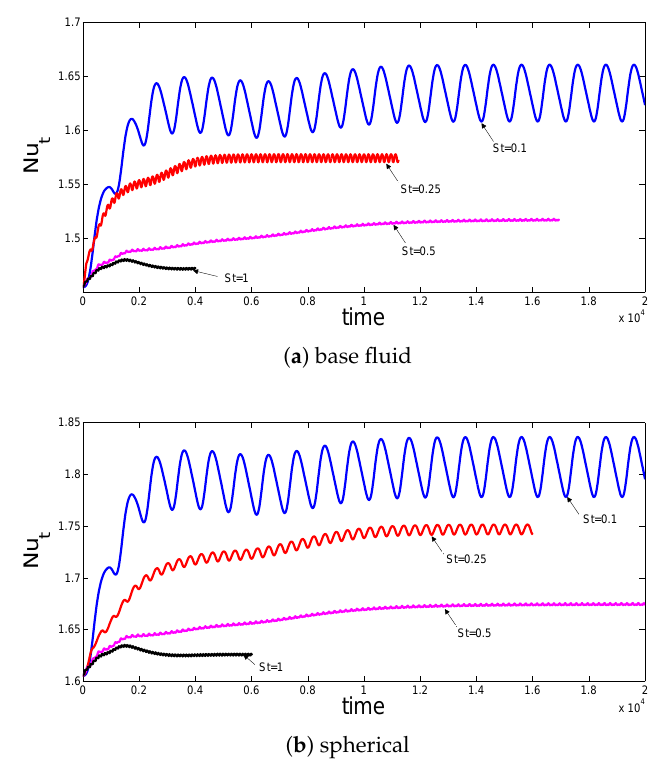
Figure 10. The effects of the Strouhal number on the spatially-averaged Nusselt number along the hot wall for water and the spherical particle shape with φ =